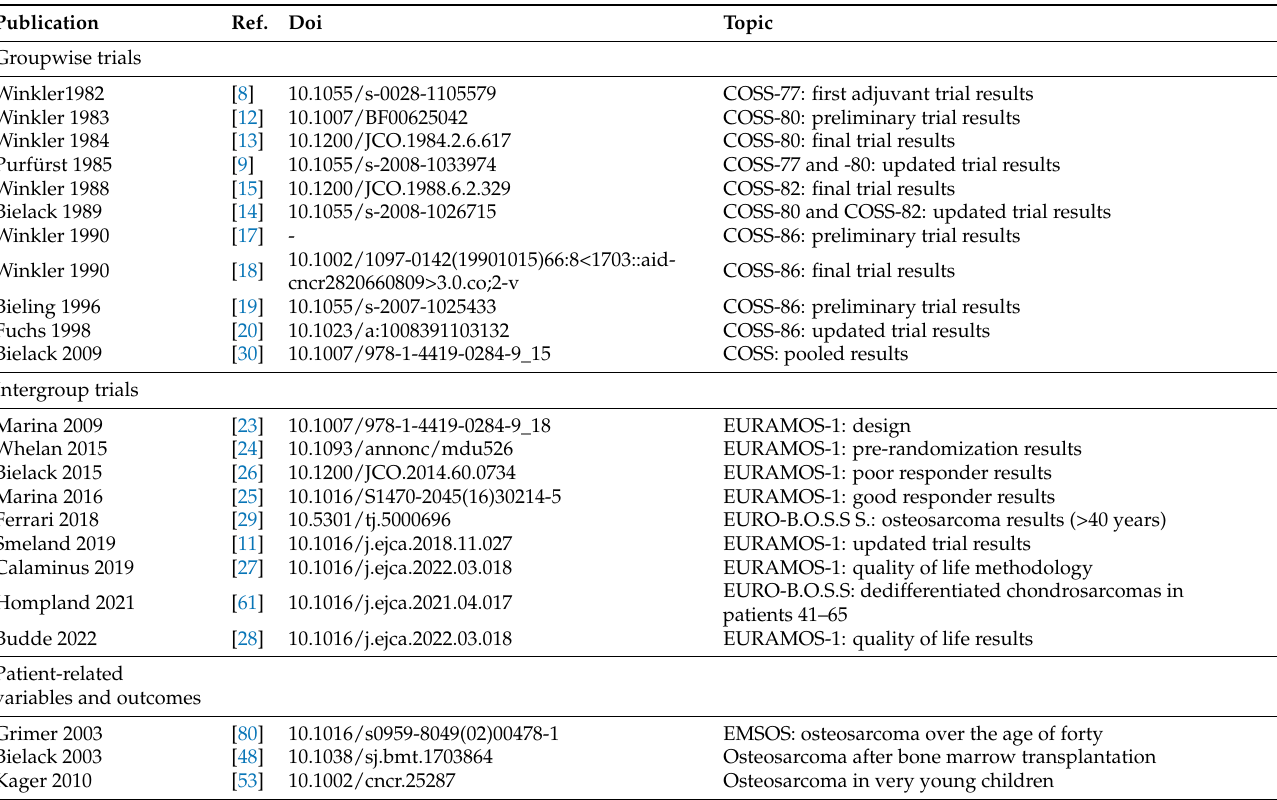
Table 1. Publications on oncological topics by the COSS group or with COSS contribution. Results relate to osteosarcoma and to COSS patients as long as not explicitly stated